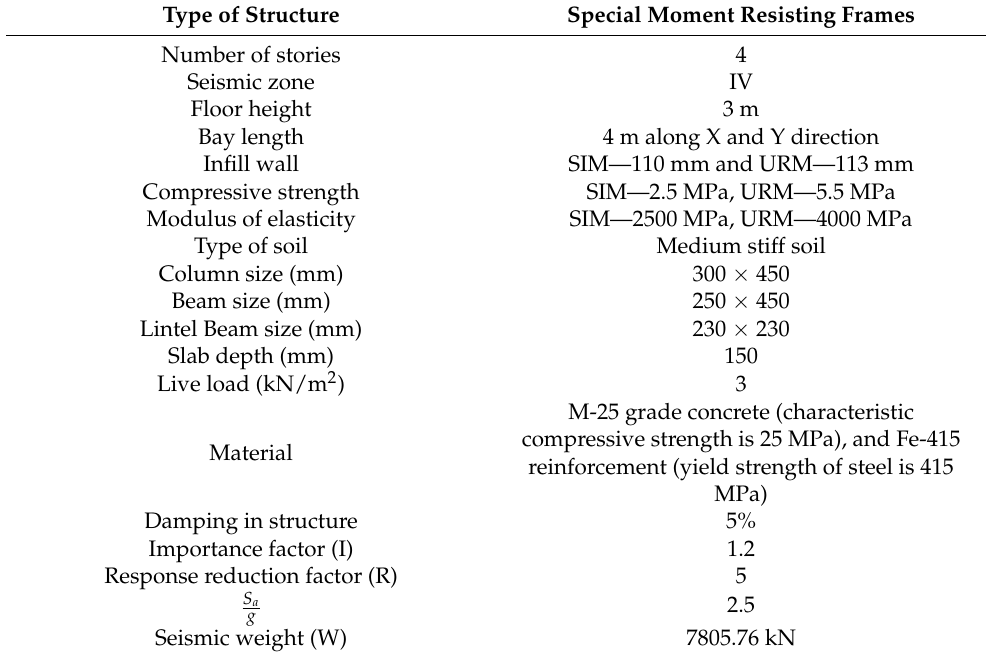
Figure 5. ( a ) 3D model of full RC-SIM infill with lintel beam; ( b ) Plan of the case study building. Table 1. Structural details of the building.